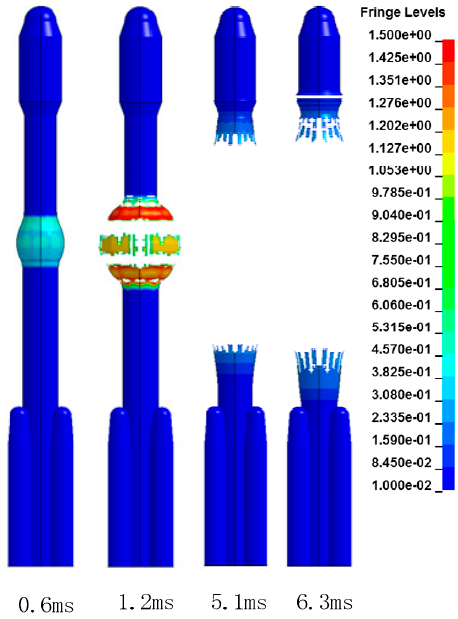
Figure 6. Strain contours at different moments of stage-3 explosion.